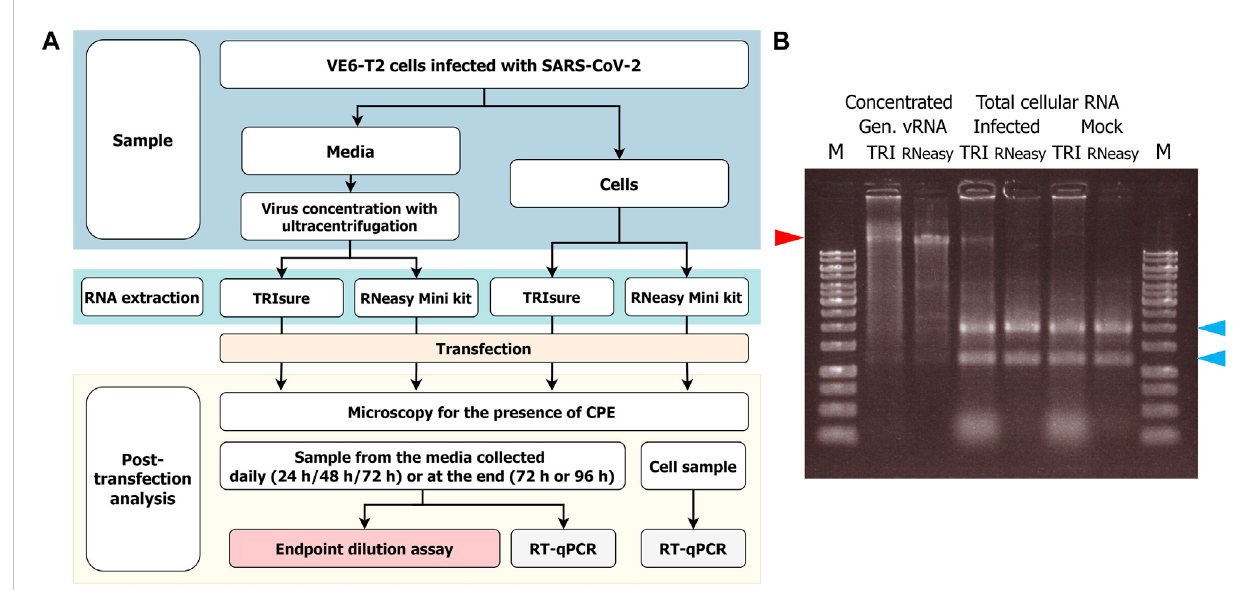
FIGURE 1 (A) Flowchart of the RNA transfection experiments and infectivity analysis. VeroE6-TMPRSS2 (VE6-T2) cells were infected with a low MOI of SARS- CoV-2and vRNAwasharvested eitherfromtheculture mediaorfrominfectedcells. AfterRNAtransfectionto VE6-T2cells, cytopathiceffect (CPE)asan indication of infection was monitored, and media and cell samples were collected during 3 – 4 days of incubation. The infectious viruses in the media samples were titrated with cultivation in VE6-T2 cells in an endpoint dilution assay, or vRNA was quanti fi ed from the media or cell samples with RT- qPCR with SARS-CoV-2 E gene speci fi c assay (negative control wells). (B) Gel analysis of the RNA on a native agarose gel. RNA samples (1 µg/well) were run on a 0.8% native agarose gel. RNA samples in the native state can form secondary structures that may run faster or differently than linear DNA ladder. Therefore, the size of vRNA or rRNA may appear lower than DNA ladder in the gel. M, GeneRuler 1 kb DNA ladder (Thermo Fisher; the highest band is 10 kb);TRI,RNAextracted withTRIsurereagent;RNeasy,RNAextracted withRNeasyMinikit.TheredarrowindicatesthegenomicvRNAofSARS-CoV-2, and blue arrows indicate 28S and 18S rRNA,